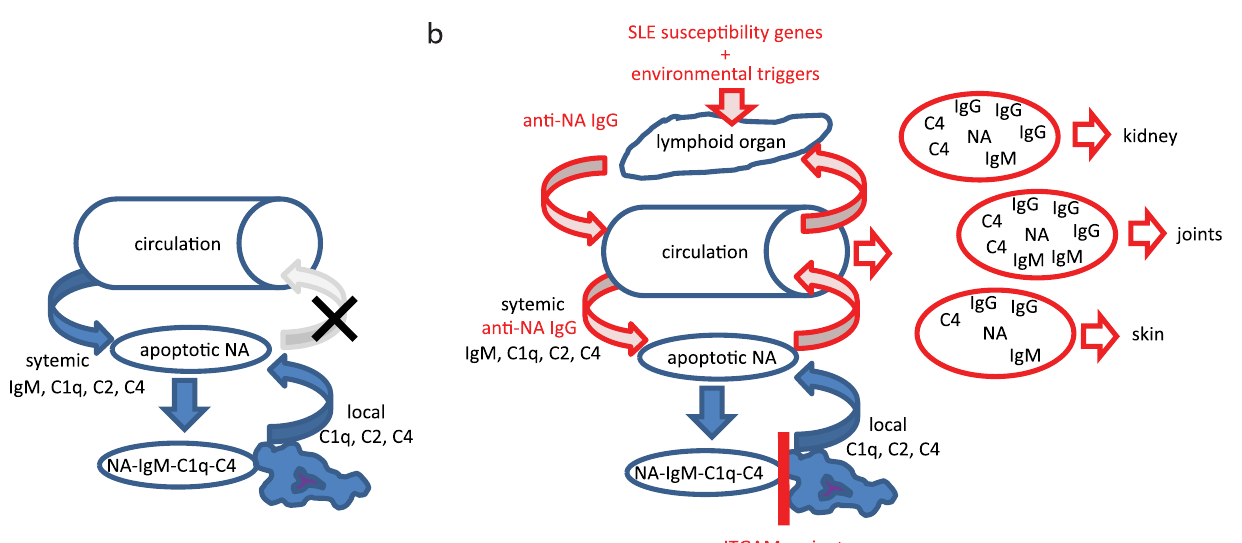
Fig 6. Scheme for the role of complement in the pathogenesis of anti-dsDNA IgG positive SLE. a . Apoptotic DNA is normally quickly opsonized by systemic IgM, C1q and early complement activation products C4 and C2, locally produced opsonins also helping removal. This opsonized debris is swiftly removed by tissue macrophages, thus the level of debris is controlled in the circulation and other organs are protected from its pathological accumulation. b . Inefficient local and systemic removal by dysfunctional CR3 encoded by ITGAM on tissue and sinusoidal macrophages results in increased levels of opsonized debris in the circulation. Circulating immune complexes reach lymphoid organs and trigger production of antigen specific antibodies. In the presence of other SLE susceptibility genes and environmental triggers high avidity DNA specific IgG develops. Upon reaching the circulation this IgG enhances complement consumption by apoptotic DNA and triggers FcgammaR mediated inflammation in tissues where immune complexes are deposited. Relative IgG, IgM and C4 content of immune complexes may influence tissue deposition preference.